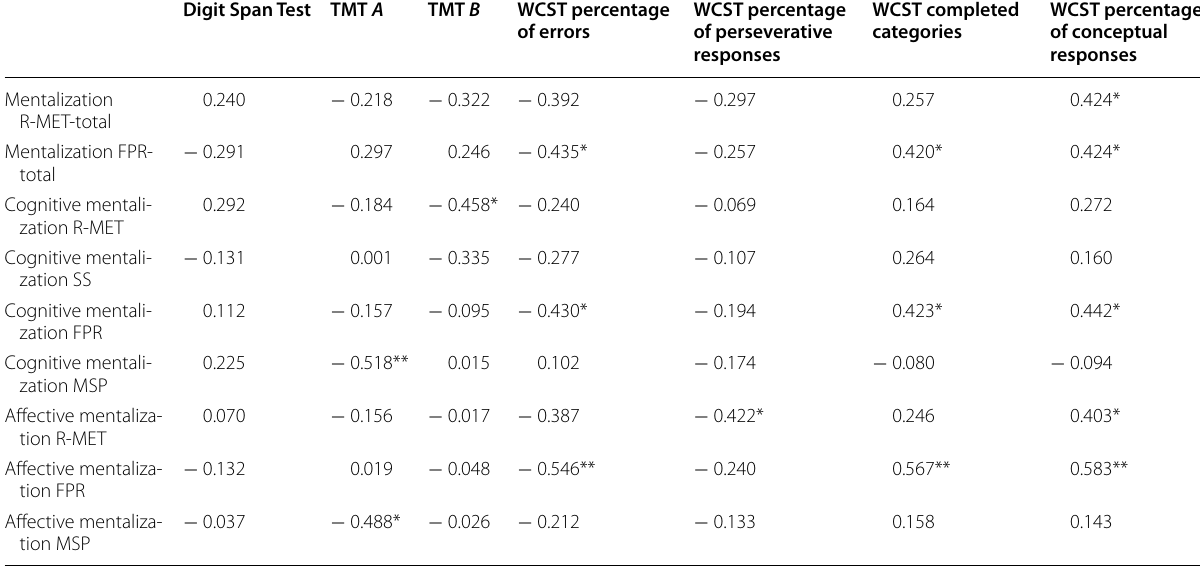
Table 4 Relationship between mentalization assessed by the Reading the Mind in the Eyes (R-MET), Strange Stories (SS), Faux Pas Recognition (FPR), and Moving Shapes Paradigm (MSP) tests and the results of cognitive function tests: a corre- lation analysis in a manic